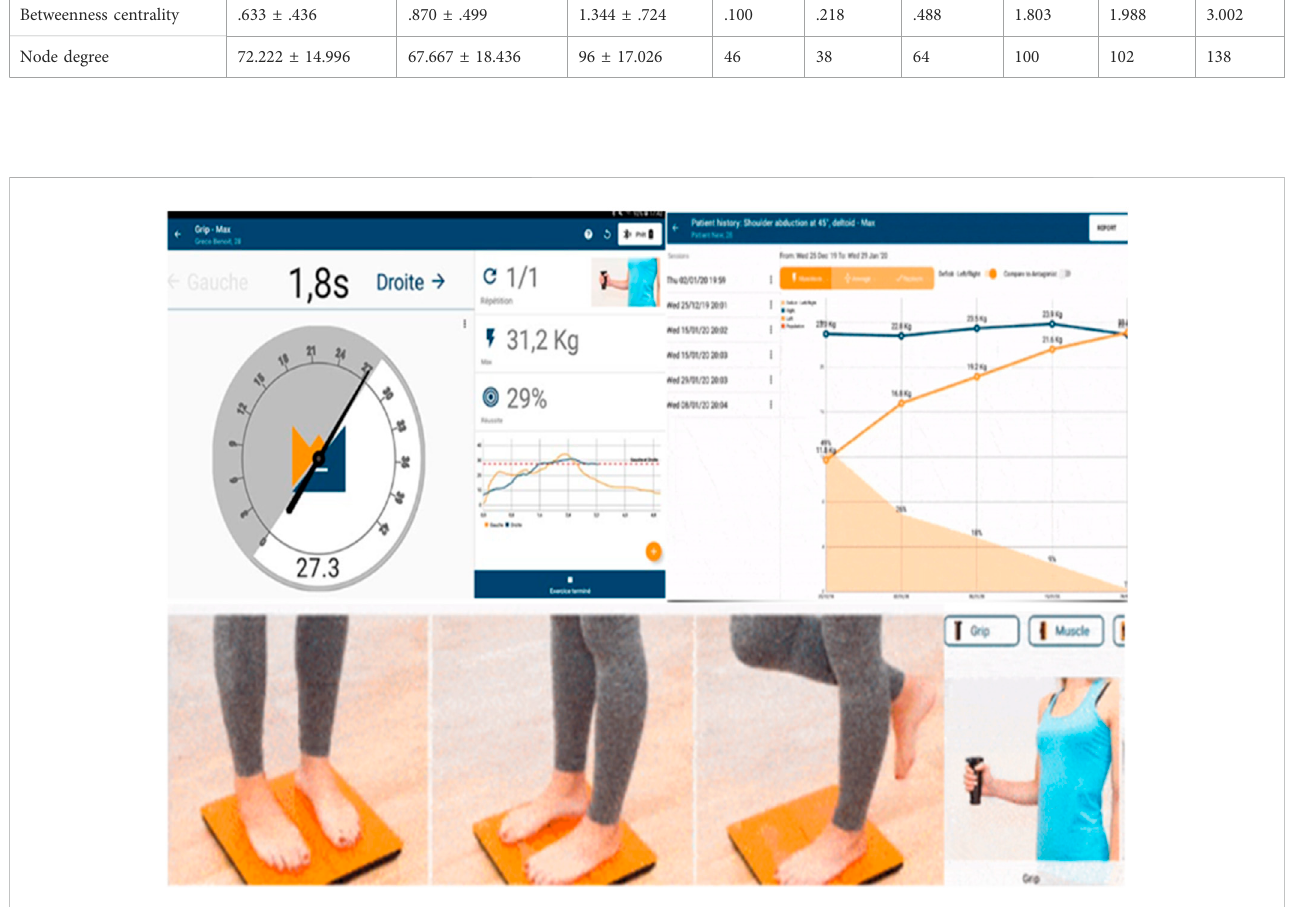
FIGURE 3 Max. grip strength dynamometer assessment (patient at the right lower corner) with the results at the left upper corner and the improvement of the studyingperiod.PosturographyK-FORCEplates,asseenattheleftlowercorner,forpostureandstanceevaluation,centerofpressure,andweightdistribution